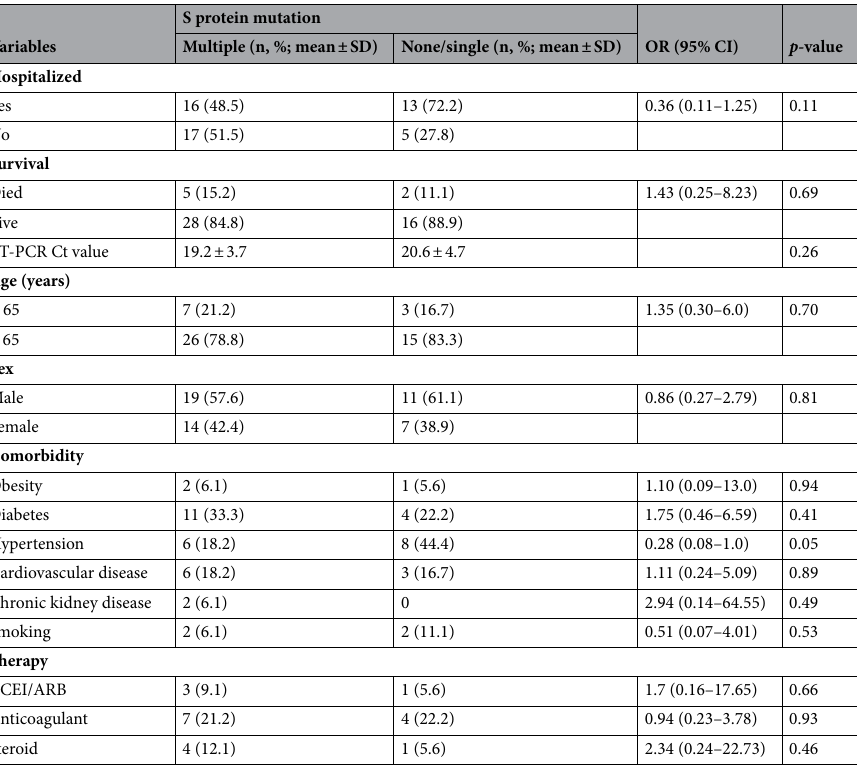
Table 4. Association between multiple S protein mutations with outcomes of patients with COVID-19 and prognostic factors. *Significant. ACEI angiotensin-converting enzyme inhibitors, ARB angiotensin receptor blocker, CI confidence interval, OR odds ratio.